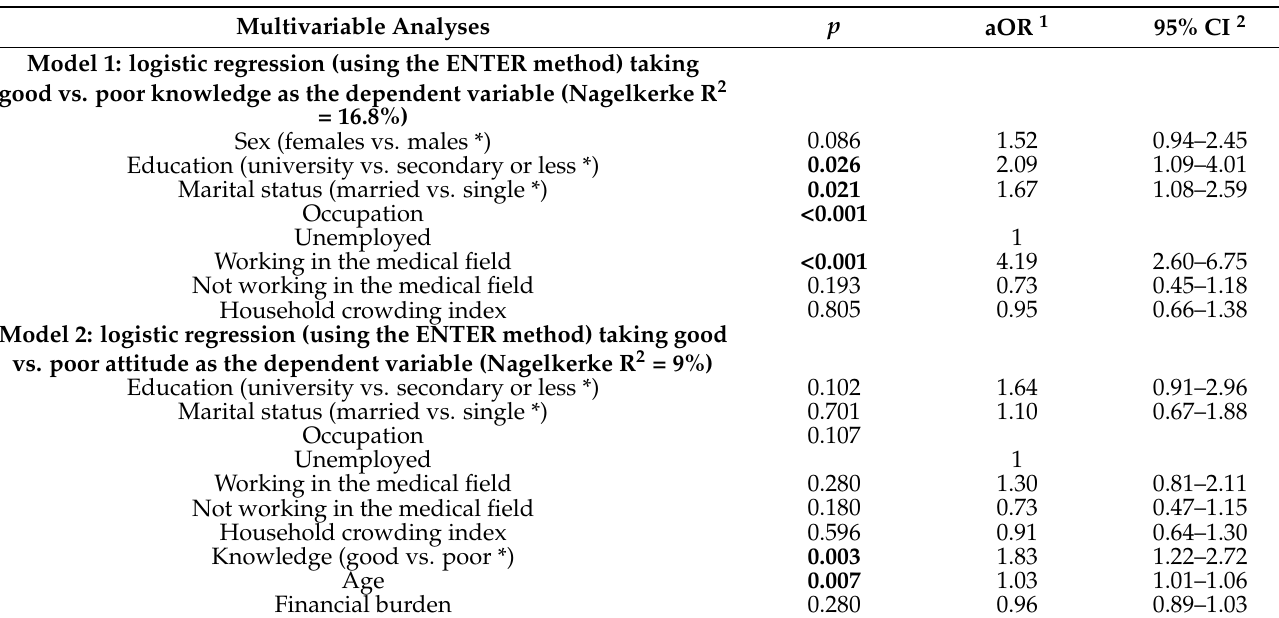
Table 6. Multivariable